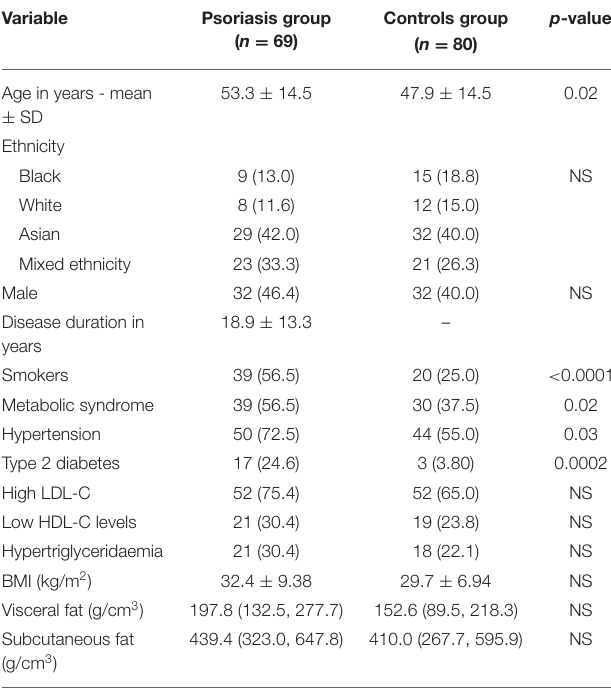
TABLE 1 | Clinical characteristics of patients and